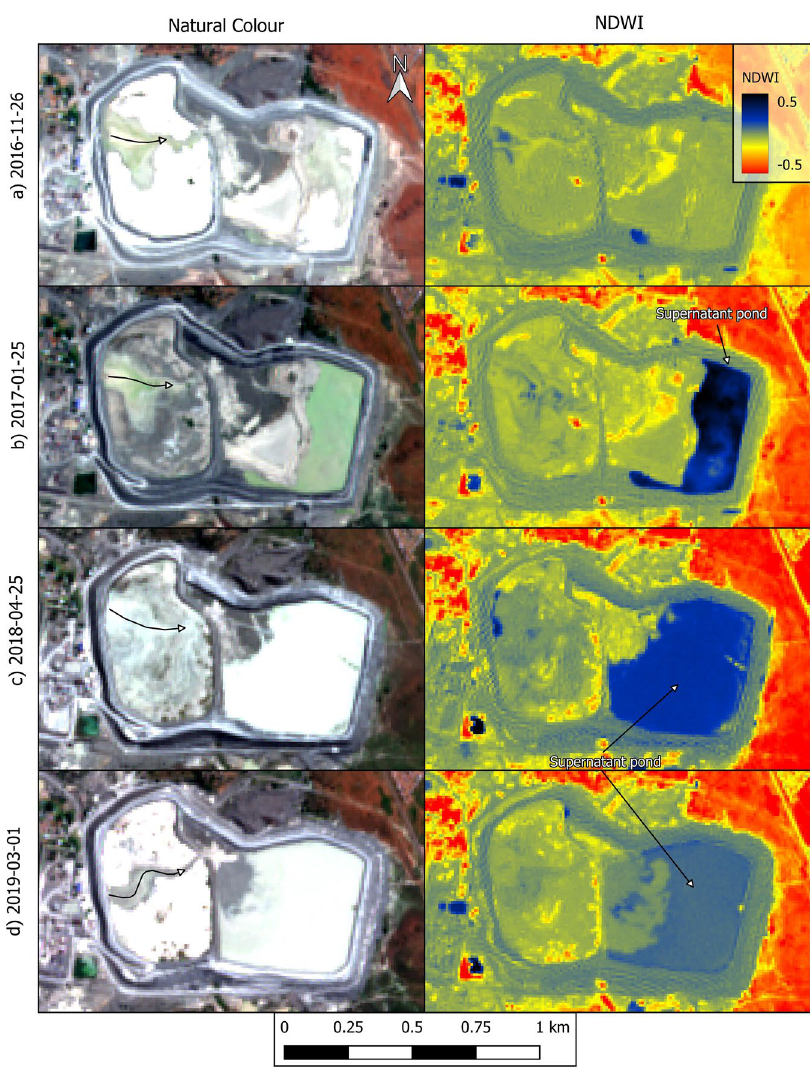
Figure 4. Natural colour and NDWI renderings of Sentinel-2 images captured from 2016 to 2022. Natural colour renditions of parts ( a ) to ( d ) show eastward migration of tailings after initial deposition in the west expansion. NDWI renditions of parts ( b ) to ( d ) show a large supernatant pond located against the perimeter wall. Natural colour rendition of part ( e ) shows eastward migration of tailings after initial deposition in the west expansion. NDWI renditions of parts ( f ) and ( g ) show a large supernatant pond located against the perimeter wall. There is no discernible supernatant pond in part ( h ), captured 5 days before failure. NB: curved arrows indicate the inferred eastward migration of tailings after deposition. Created using QGIS software version 3.26 (http:// www. QGIS.